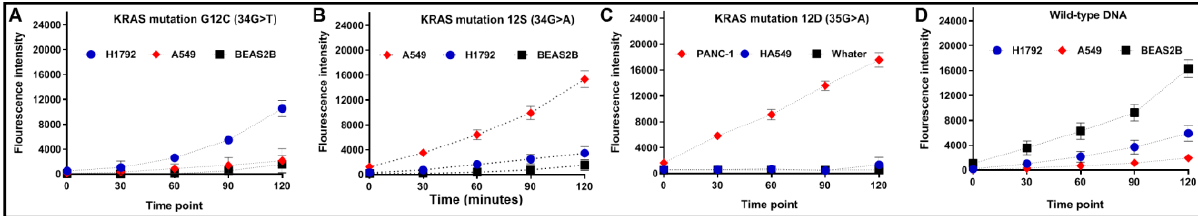
Figure 2. Time courses of fluorescence detection of CRISPR–Cas12a with specific crRNAs in cell lines: ( A ) fluorescence intensity of CRISPR–Cas12a with specific crRNA targeting KRAS 12C significantly raised with an increase in reaction time in DNA of H1792 cells that had G12C mutation ( p = 0.011); ( B ) fluorescence intensity of CRISPR–Cas12a with specific crRNA targeting KRAS 12S significantly elevated with the reaction time in A549 cells that had G12S mutation ( p = 0.003); ( C ) fluorescence intensity of CRISPR–Cas12a with specific crRNA targeting KRAS 12D significantly elevated with the reaction time in PANC-1 cells that possessed G12D mutation ( p = 0.001); and ( D ) fluorescence intensity of CRISPR–Cas12a with specific crRNA targeting wild-type KRAS increased with the reaction time in BEAS2B cells that had wild-type KRAS ( p = 0.008).